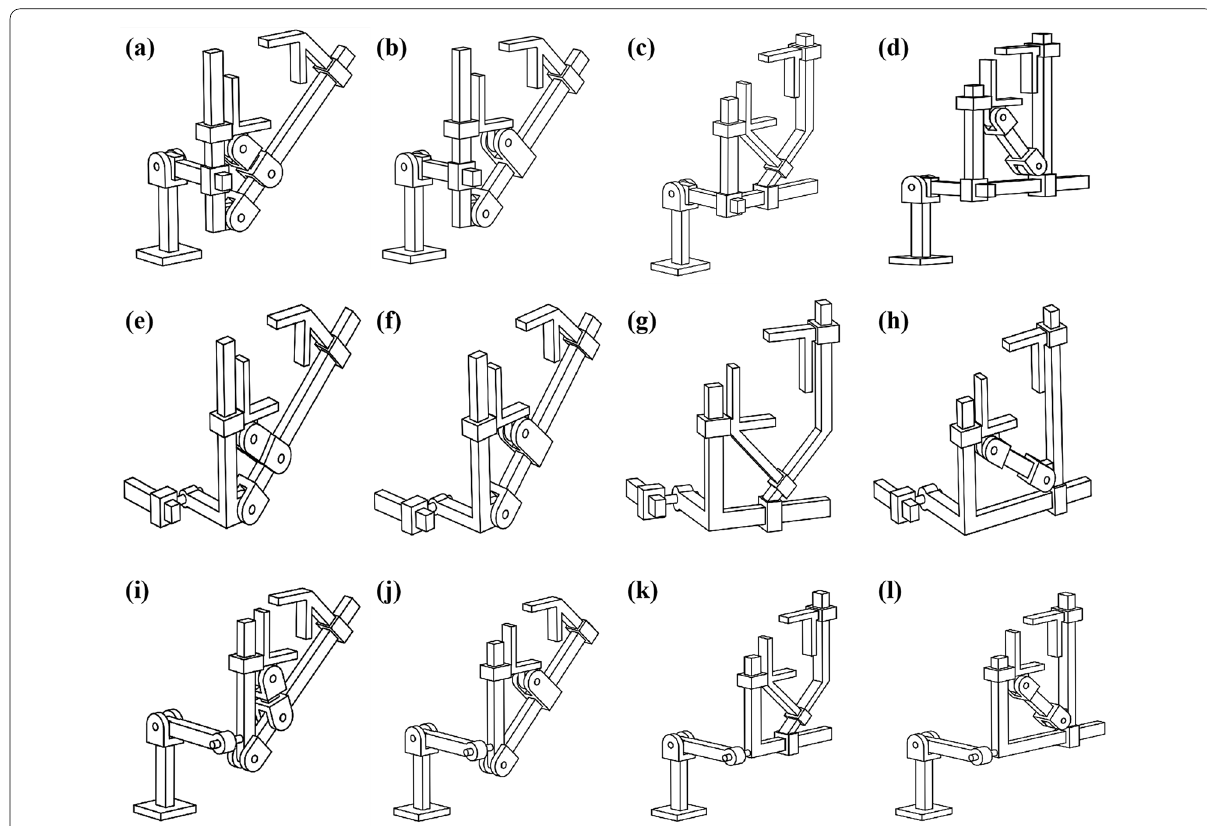
Figure 8 Single-side basic structures of steel arch splicing manipulators